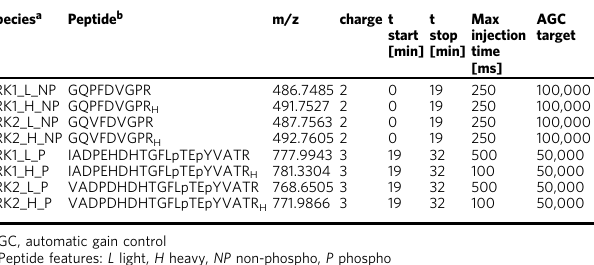
Table 1 Heavy peptide standard sequences for quanti fi cation of phosphorylated and non-phosphorylated ERK1 and ERK2 by mass